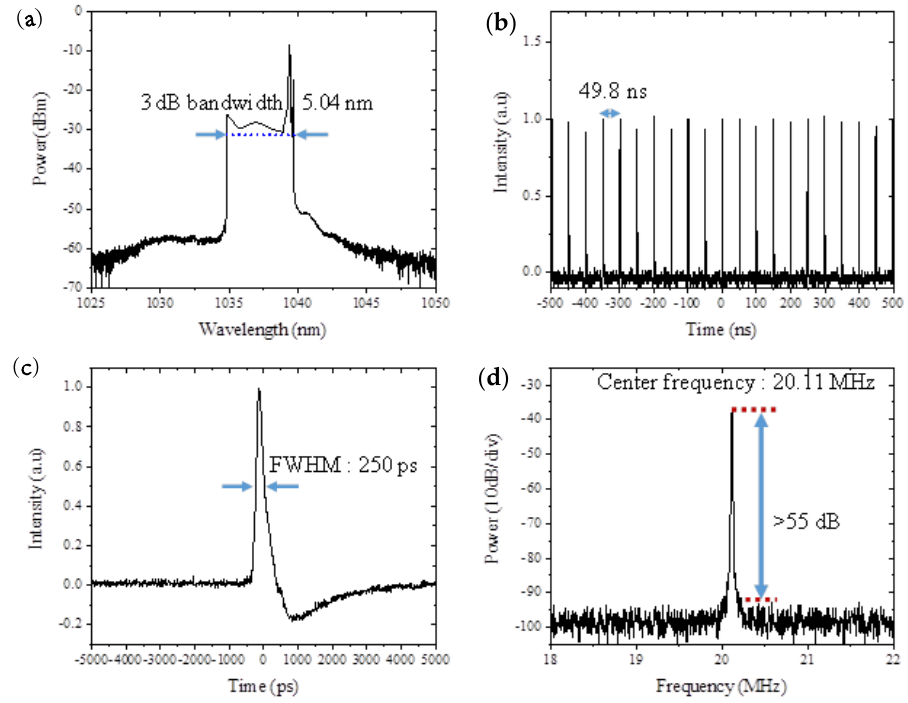
Figure 5. Characteristics of the 1 µ m mode-locked pulse laser at a pump power of 247 mW: ( a ) optical spectrum; ( b ) oscilloscope trace; ( c ) high-speed oscilloscope trace and estimated pulse duration; ( d ) RF spectrum.